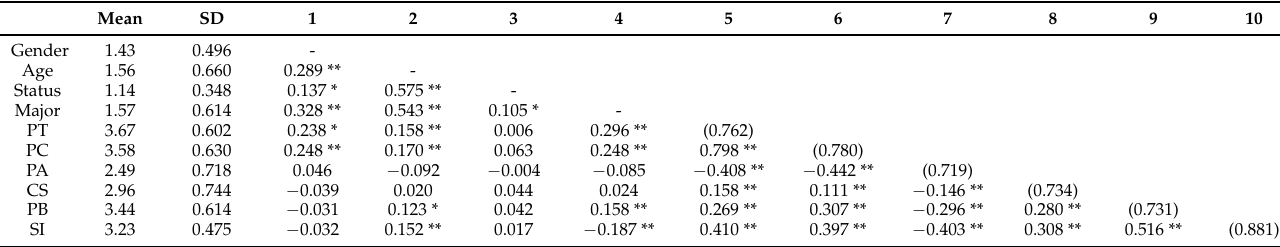
Table 1. Correlation statistics (N =